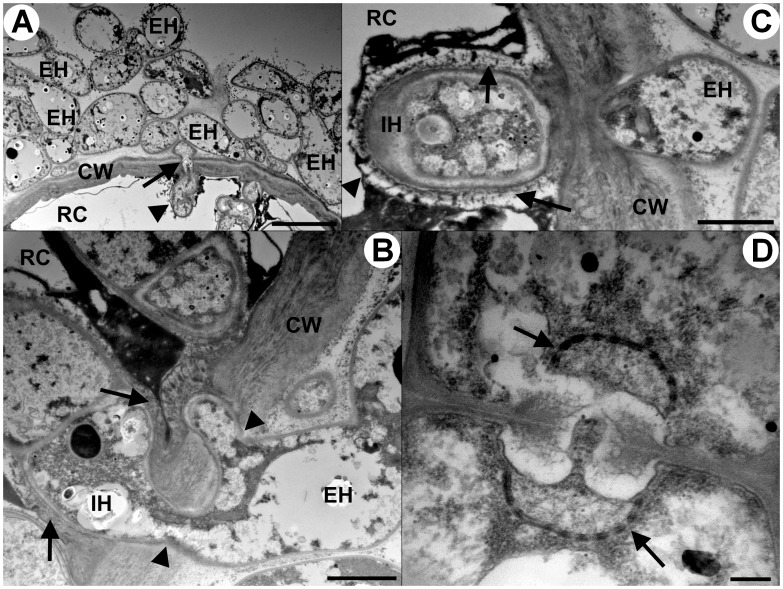
Transmission electron microscopy of sheathed ericoid mycorrhizae synthesized in vitro between the basidiomycete JPK 87 and Vaccinium vitis-idaea.
1A) Transversal section through a hyphal sheath, showing abundant extraradical hyphae (EH); a hypha (arrow) narrows its diameter while penetrating the host cell wall (CW) and then expands again in the lumen of a host rhizodermal cell (RC). The intracellular hypha is surrounded by the host plasma membrane (arrowhead). Bar  = 5 um. 1B) Thick extraradical hypha (EH) penetrates the cell wall (CW) of a host rhizodermal cell (RC) at two entry points (arrowheads). The intracellular hypha (IC) is surrounded by a material apparently derived from the host cell wall (arrows) deposited in the space below the host plasma membrane. Bar  = 1 µm. 1C) Extraradical hypha (EH) penetrates the host cell wall (CW), its intracellular phase (IH) is surrounded by the host plasma membrane (arrowhead) and the cell wall-derived material (arrows). Bar  = 1 µm. 1D) A dolipore with perforated parenthesomes (arrows) of an intracellular hypha. Bar  = 0.2 µm.